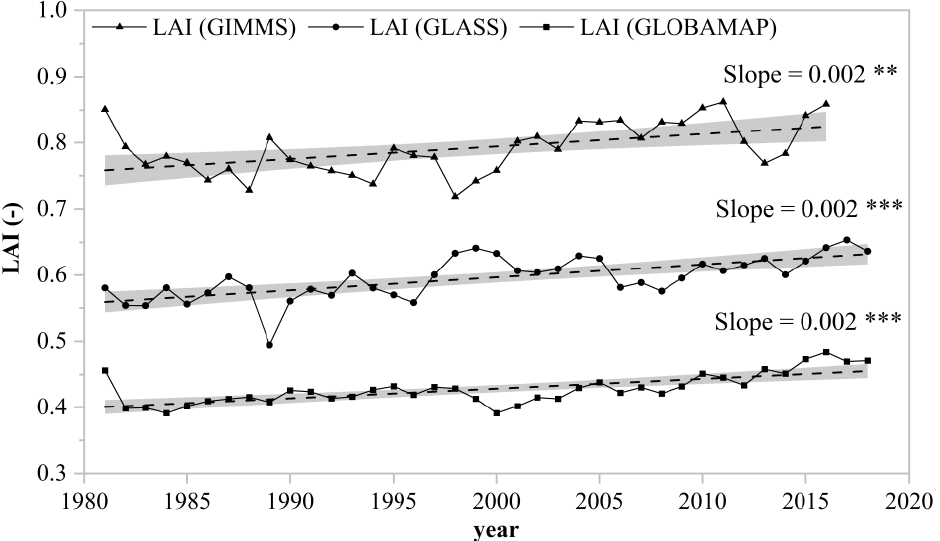
Figure 6. Temporal variation trends of the leaf area index (LAI) over the entire study area from 1981 to 2018 (**, p < 0.01; ***, p < 0.001).